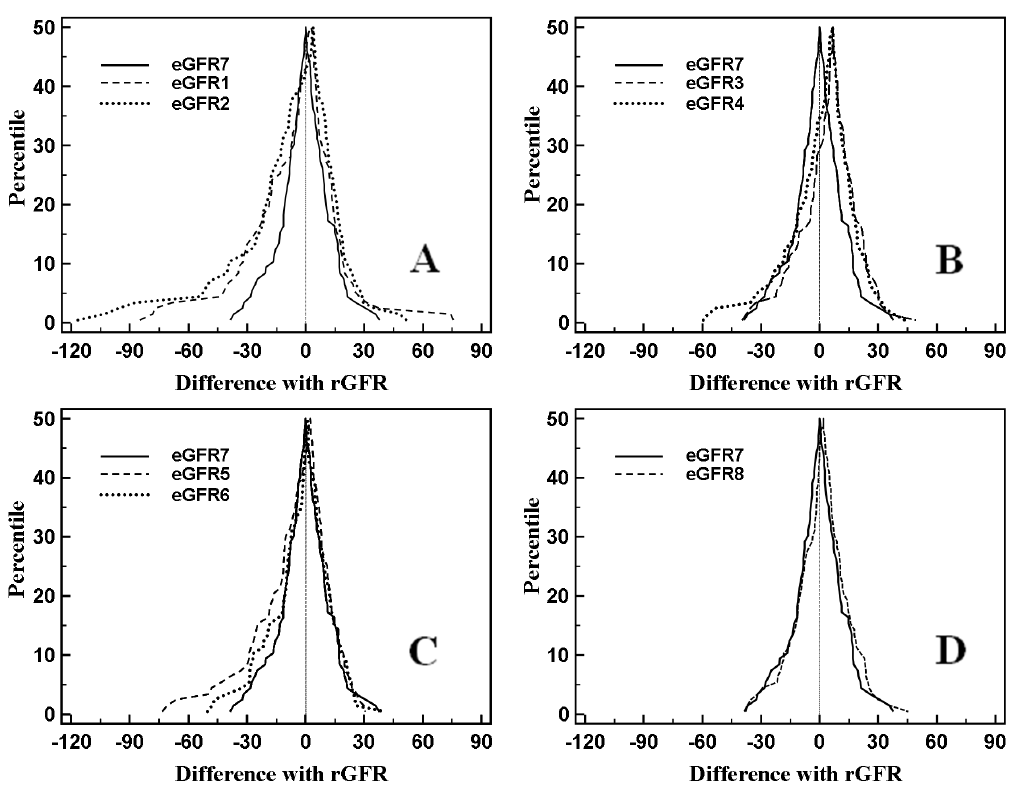
Figure 3. Mountain plot: comparison between newly developed eGFR formulas and various literature eGFR formulas.